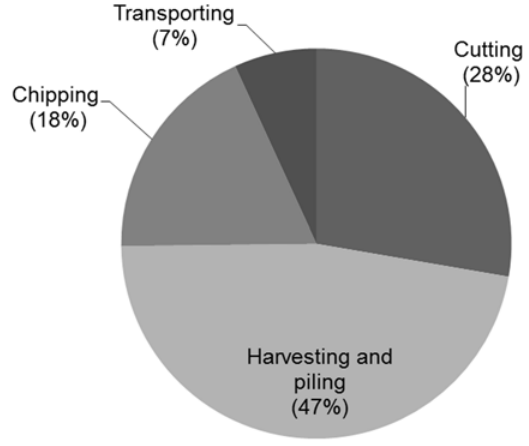
Figure 1. Manpower required in different operations.